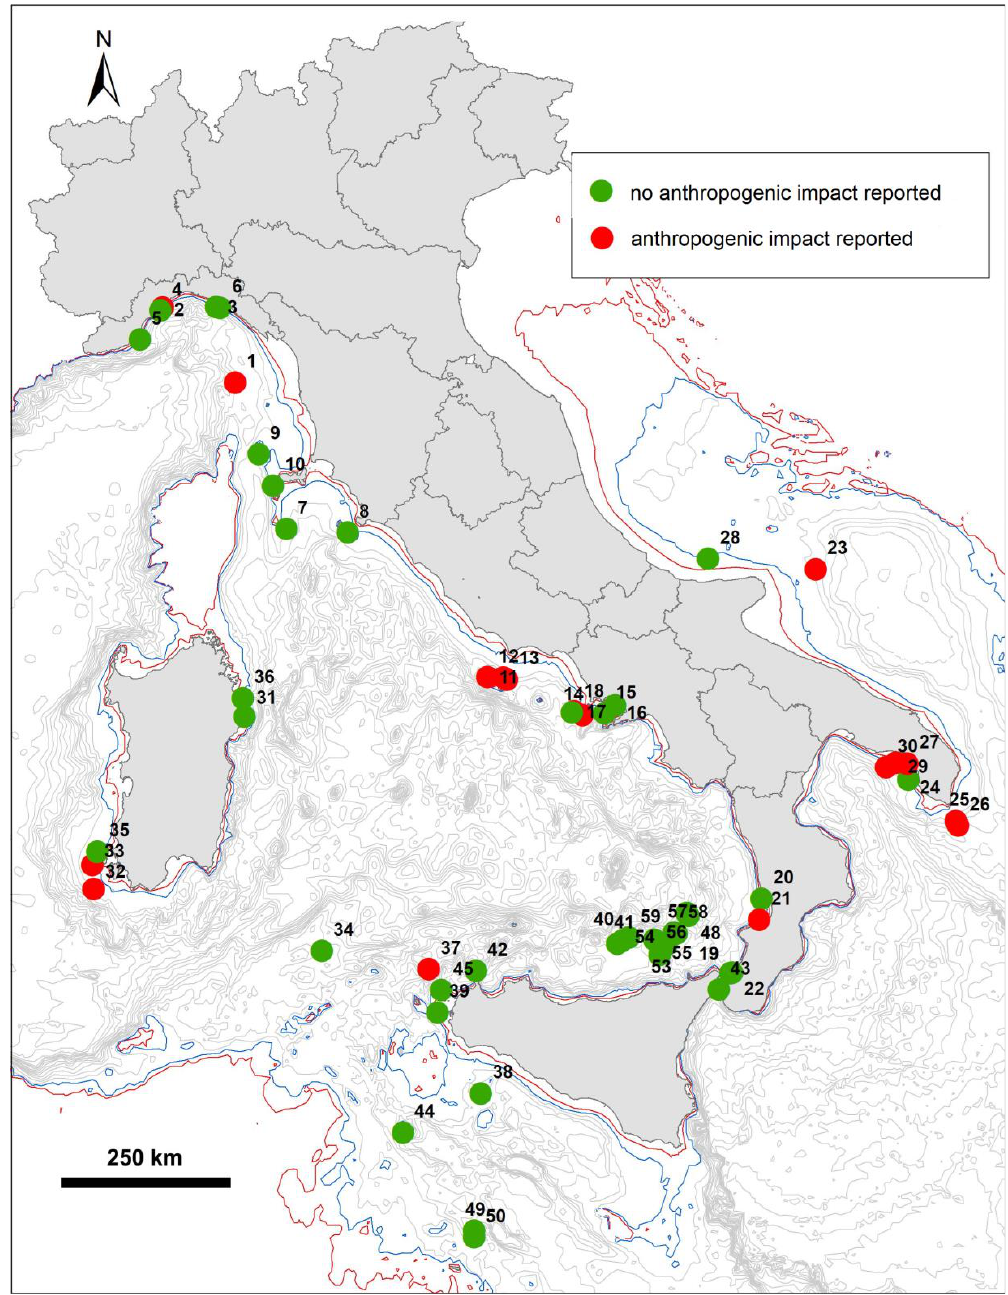
Figure 5. Map of the Italian black coral communities that are affected or unaffected by anthropogenic impact. These sites, representing 29% of the total, are found in water depths ranging from 45 m to 730.5 m (with a medium depth of 200 m), and are associated with the rocky bottom, deep rocky banks, and shoal substrates. The items affecting the black coral communities are represented by two main categories (Table 1): fishing activity (trawl and ghost nets, longlines, lines, ropes, other fishing litter) and lost garbage (e.g., plastic and metal